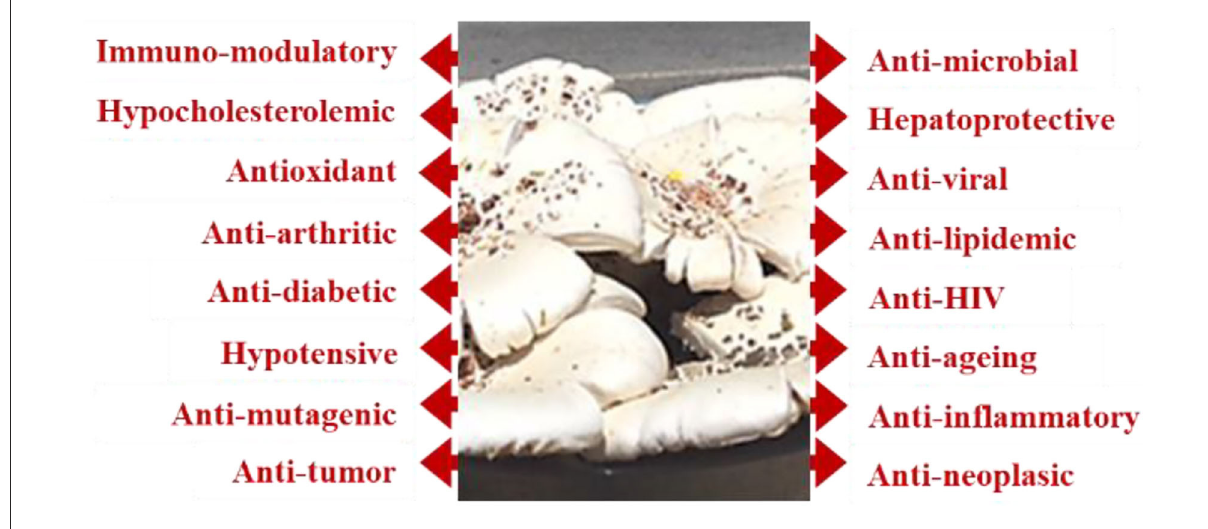
FIGURE1 Multiple roles of mushrooms in several dysfunctions and health